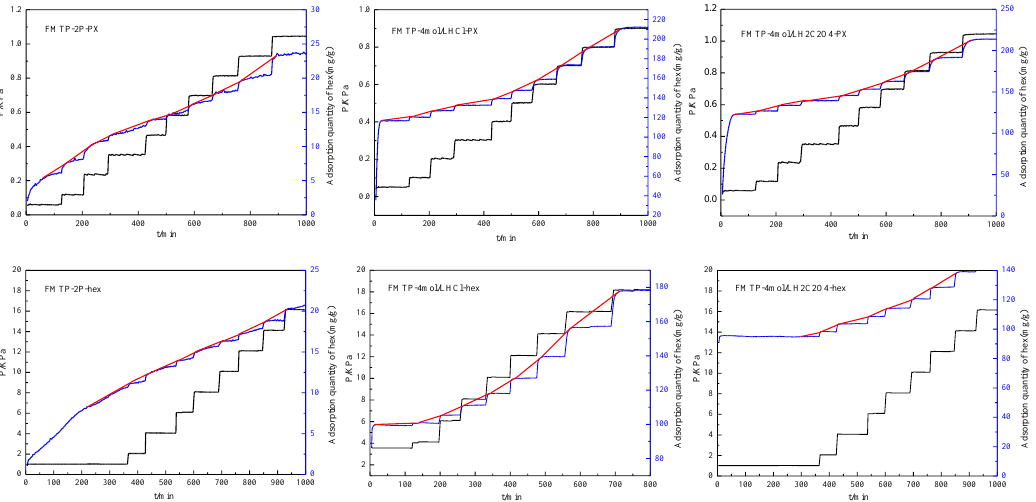
Figure 7. Relationship between sample adsorption capacity and pressure with respect to time before and after HCl and H 2 C 2 O 4 treatment.